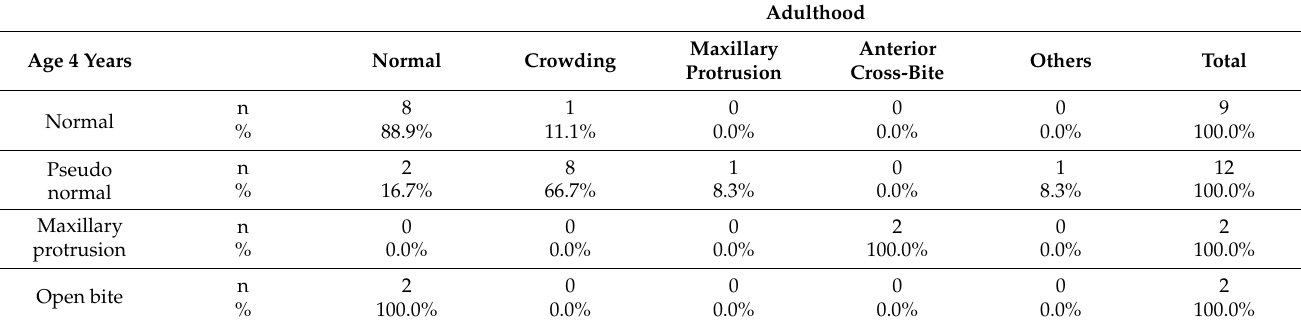
Table 6. Distribution of occlusion at 4 years of age and in adulthood.